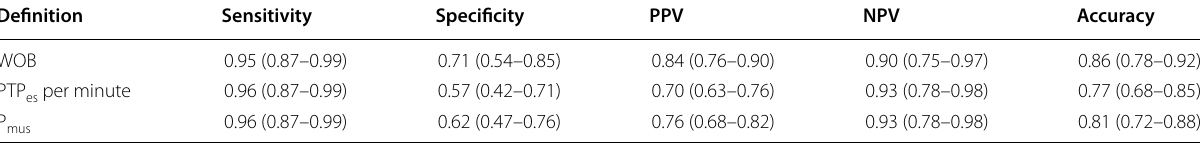
a The cutoff value of flow index derived from the present study was 2.1 Between parentheses is the 95% confidence interval (95%